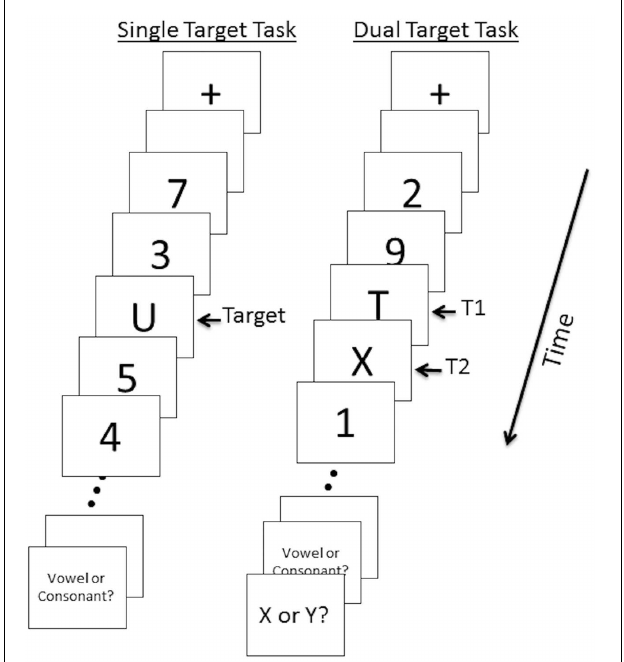
FIGURE 1 | Single and dual target RSVP task illustration. Twenty stimuli (targets and distractors) per trial were presented for 85 ms with a 15 ms interstimulus interval. A 5000 ms response period prompted participants to indicate whether T1 was a vowel or a consonant (single and dual target tasks) and whether T2 was X or Y (dual target task). In the dual target task trial shown here, T2 is presented at lag